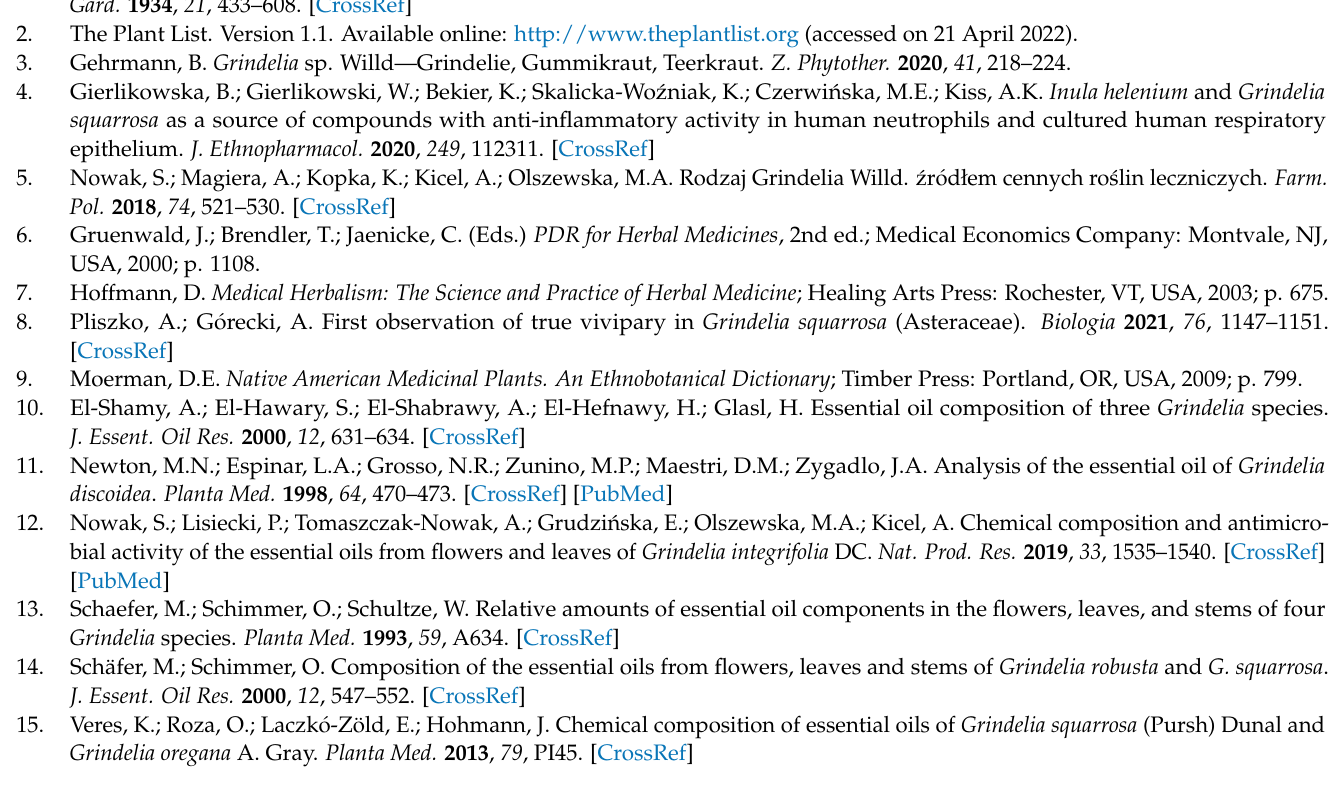
Figure S3: Camphor Enantiomers of the Grindelia squarrosa Leaf Essential Oils. Figure S4: Borneol Enantiomers of the Grindelia squarrosa Flower Essential Oils. Figure S5: Limonene Enantiomers of the Grindelia squarrosa Essential